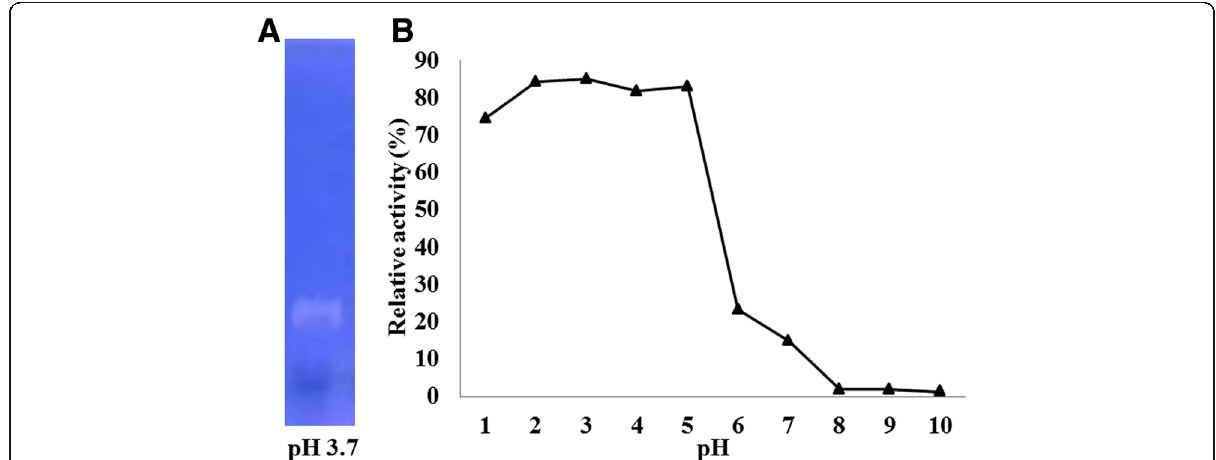
Fig. 8 The HAase activity. VesT2a: V. tropica venom was tested for specific HAase activity by the ( a ) zymographic method and ( b ) optimal pH using turbidimetric assay. For the zymogram HAase activity assay, samples were analysed using 10 % SDS-PAGE containing hyaluronic acid under reducing conditions. The zymgraphic gel was developed overnight at 37 °C under pH 3.7. For the turbidimetric assay, the enzymatic activity of VesT2a, V. tropica venom was tested at various pHs using hyaluronic acid as a substrate at 37